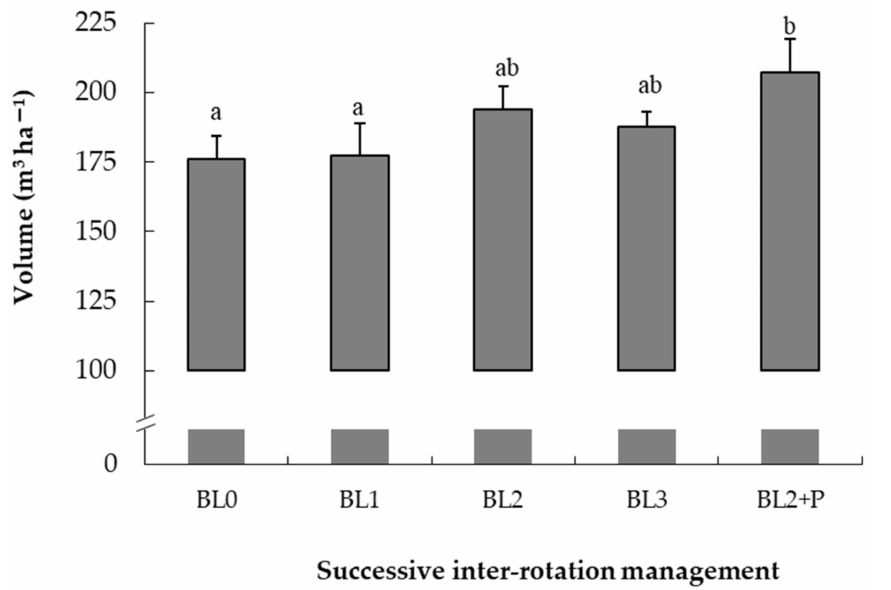
Figure 2. The legacy effects of inter-rotation management over three successive rotations of Aca- cia mangium on stem volume of Eucalyptus pellita at age 6 years. Vertical bars are SE of means. Treatments having the same letter are not significantly different according to Duncan multiple range test at α = 0.05.